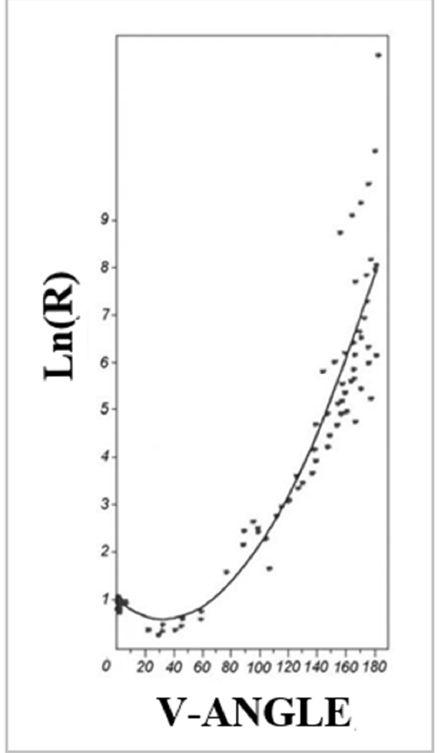
Figure 13. Basis for the model generating an early intermediate structure using an analysis of geometric parameters–dependence of R (logarithm scale) on the V ‐ angle—a parabolic curve was determined by approximating the points representing low ‐ energy areas on the Ramachandran map.